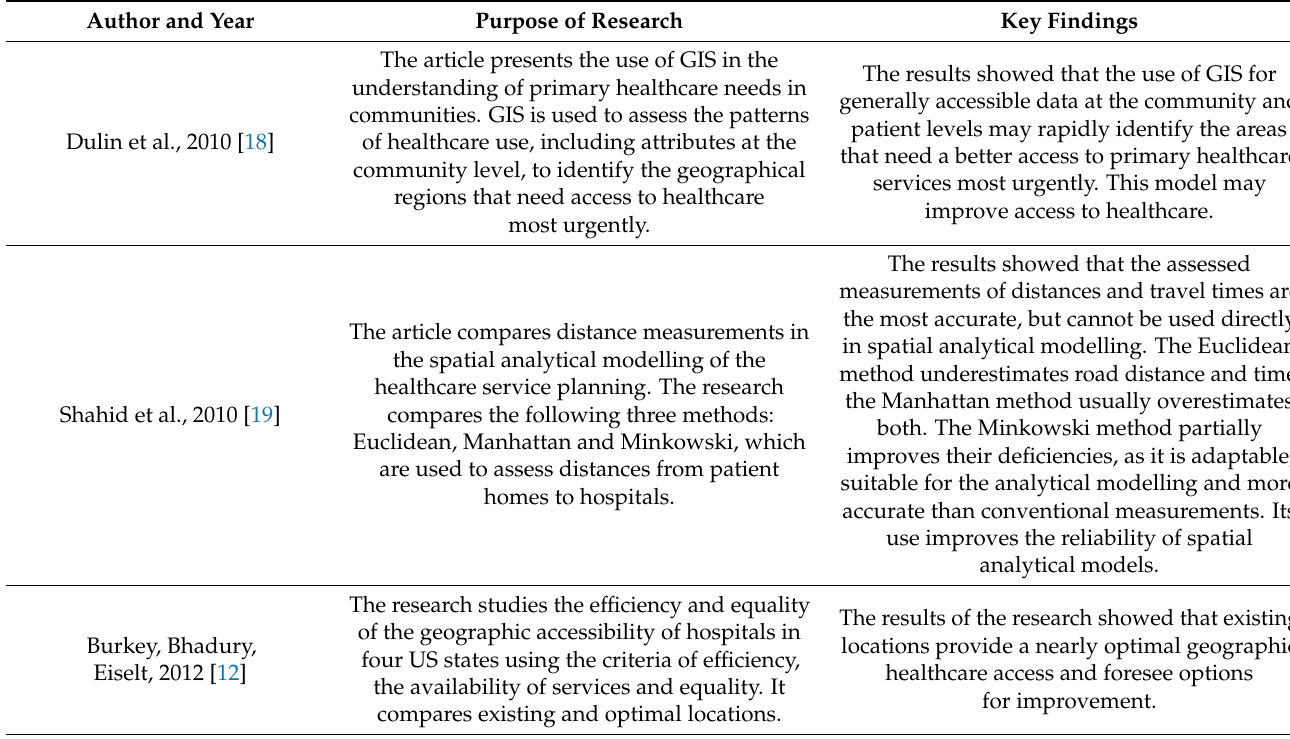
Table 3. Description of studies included in the literature